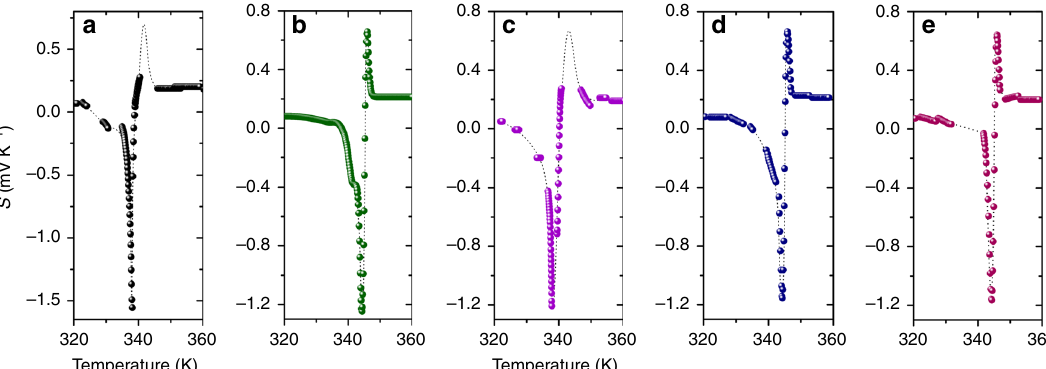
Fig. 3 Reproducibility of Seebeck coef fi cient data in Cu 2 Se. a − e Representative series of Seebeck coef fi cient data acquired on Cu 2 Se, prepared by the same method and having the almost identical chemical composition and thickness of 1.3 mm, in a range of the abnormal behavior